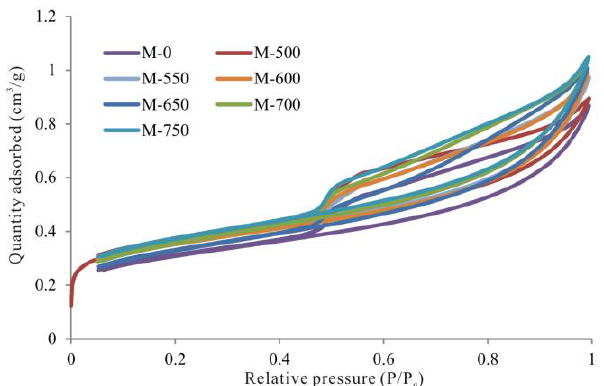
Figure 4. N 2 adsorption isotherms for samples at different temperatures.